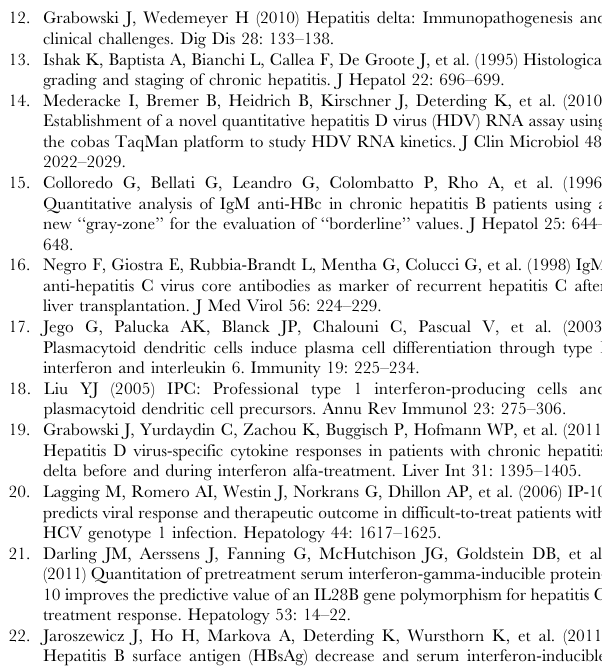
Figure S1 Evaluation of the anti-HDV IgM assay indicated deviations of the optical density values based on variation in time. Table S1 All measured cytokines, chemokines and angiogenic factors associated with the groups of anti- HDV IgM based on ANOVA